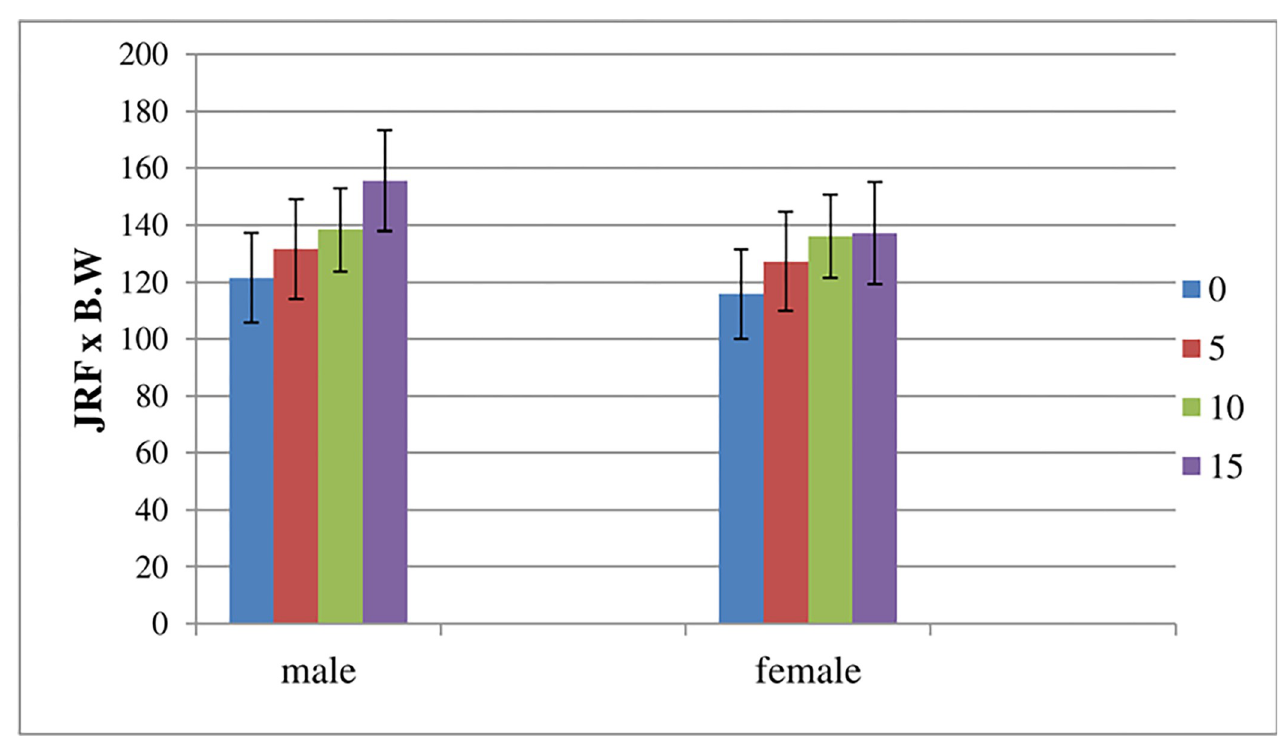
Fig 2. The variation of the resultant hip joint reaction force between males and females during single-limb support on the four walking ramps.